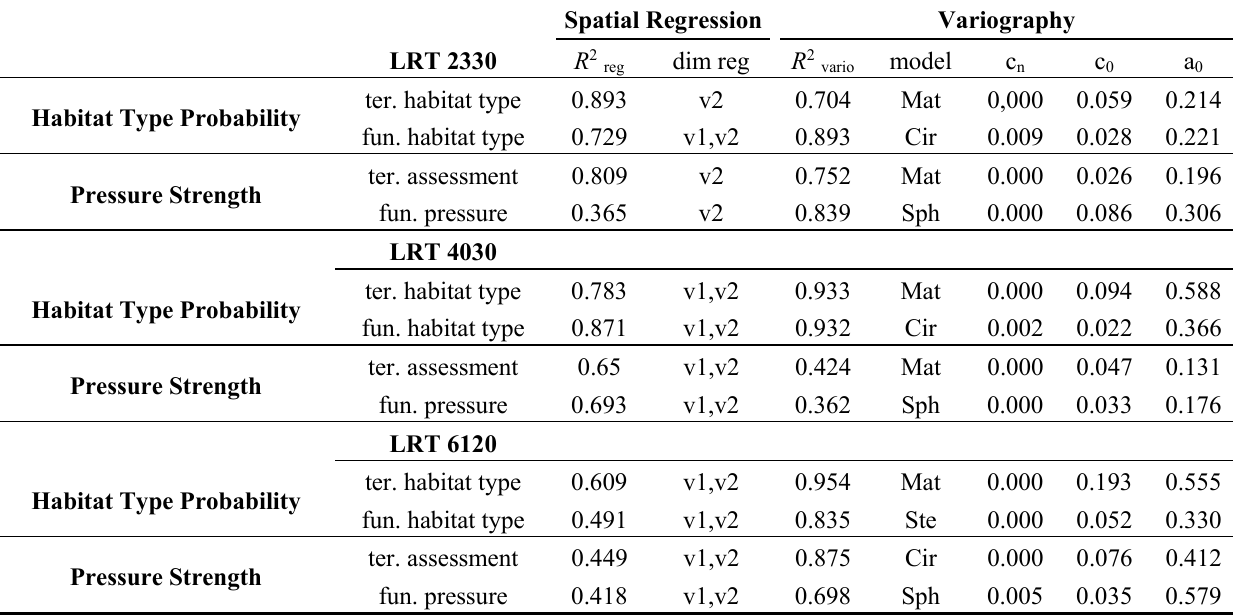
Table 2. Variogram models for field-survey-based habitat types and habitat conservation status assessment (ter.), and for habitat-functions-based habitat types and pressure strength (fun.). Mat = Matern with kappa = 5; Cir = circular; Sph = spherical; Ste = Matern with M. Stein’s parameterization; c n = nugget; c 0 = sill; a 0 = effective range; R 2 vario = coefficient of determination for variogram models; R 2 reg = coefficient of determination for coordinate regression; dim reg = significant dimensions (v1, v2) in spatial